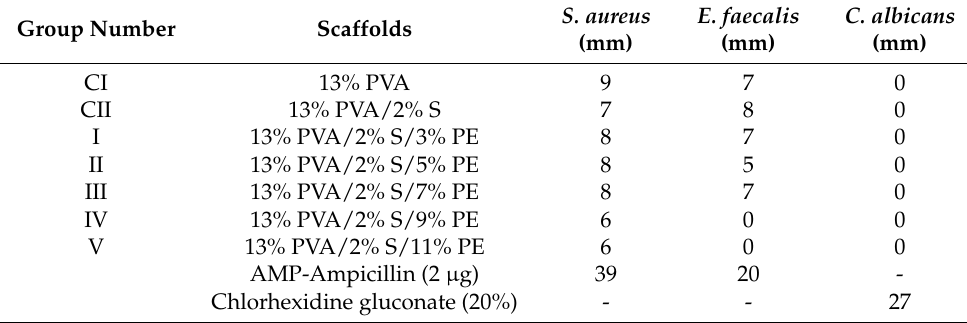
Table 4. The inhibition zone diameters of the control groups and scaffolds. Group Number